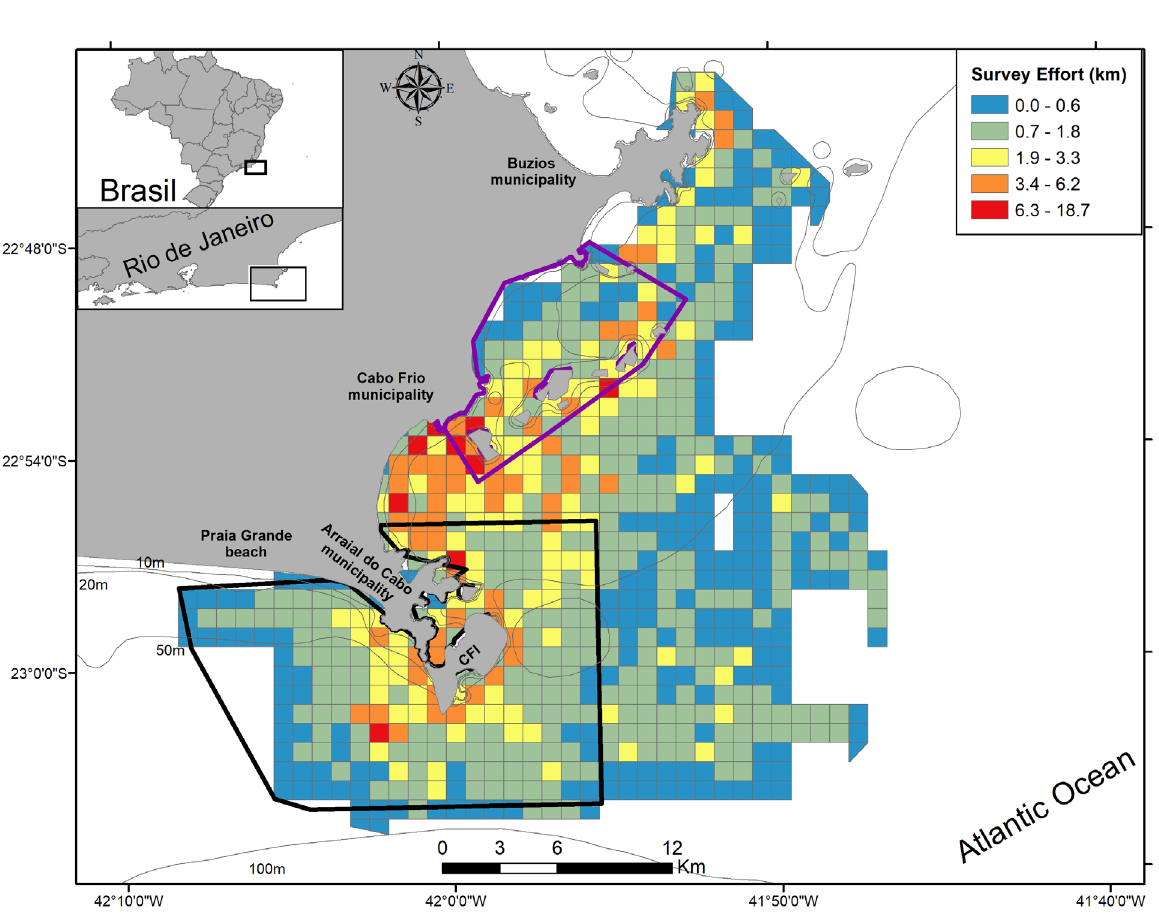
Figure 1. Study area located in Southeastern Brazil, Rio de Janeiro, showing isobaths. Survey effort is shown in map for each 1x1 km 2 grid. Continuous blue line indicates Marine Protected Area (MPA) Reserva Extrativista Marinha do Arraial do Cabo and purple line MPA